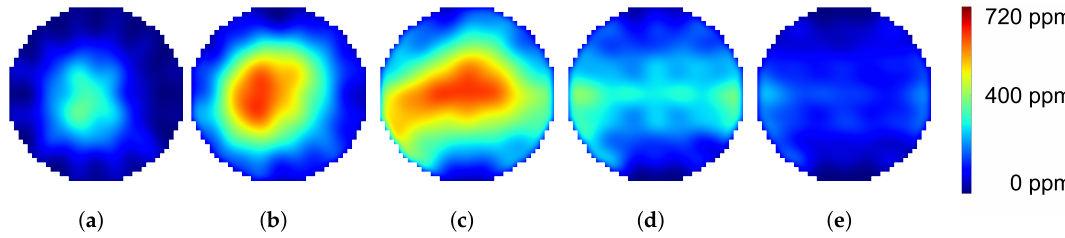
Figure 10. The images ( a – e ) show the reconstruction results of measurements from the hot gas test